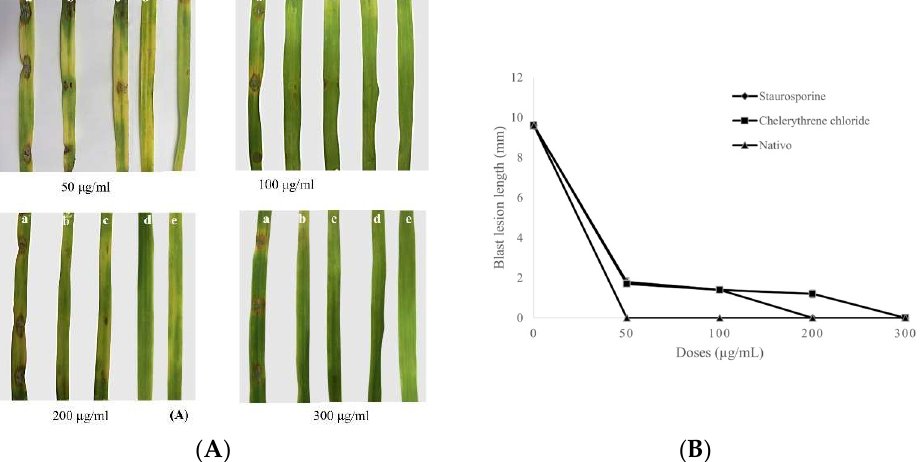
Figure 6. Suppression of wheat blast disease by staurosporine, chelerythrine chloride at 50 µg/mL, 100 µg/mL, 200 µg/mL, and 300 µg/mL on representative detached wheat leaves inoculated with Magnaporthe oryzae Triticum. ( A ) Blast lesions on treated and untreated wheat leaves. (a) MoT inoculation after treatment of leaf with water (control). (b) MoT inoculation after treatment of leaf with staurosporine. (c) MoT inoculation after treatment of leaf with chelerythrine chloride. (d) MoT inoculation after treatment of leaf with Nativo ® 75WG. (e) Non-inoculated after treatment with water. The experiment was repeated 5 times and only the representative images are shown. ( B ) Blast lesion lengths on detached wheat leaves treated with staurosporine, chelerythrine chloride, and Nativo ® 75WG fungicide compared with water treatment (control). The data are the averages ± standard errors of at least five replicates for each dose of the tested compounds at p ≤ 0.05. Bars represent ± standard error.